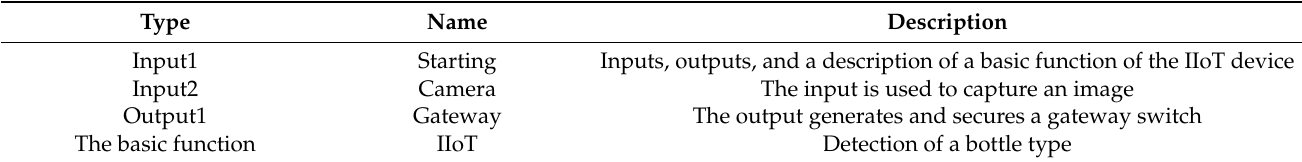
Table 3. Inputs, outputs, and a description of a basic function of the IIoT device.